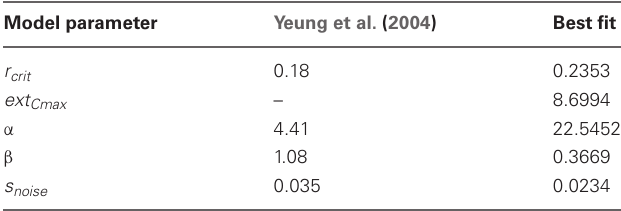
Table 1 | Comparison of model parameters from the best fit of the present model and the original model by Yeung et al.